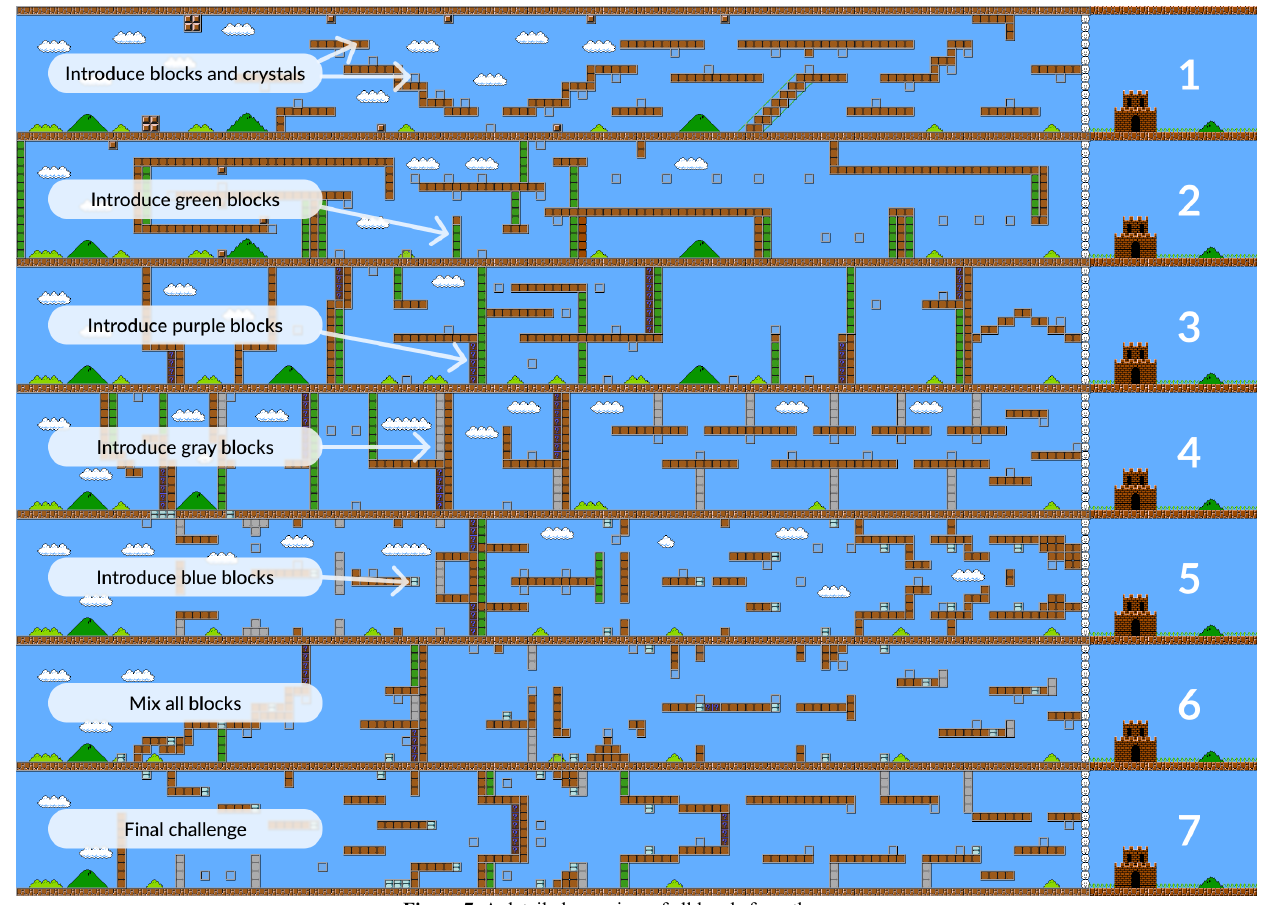
Figure 7. A detailed overview of all levels from the game.